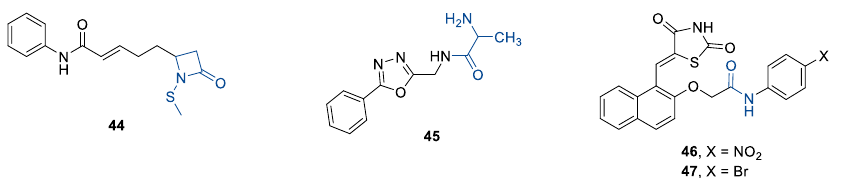
Figure 8. Structure of non-hydroxamate HDAC8 inhibitors ( 44 – 47 ); the predicted ZBGs are in blue [151 – 155]. blue